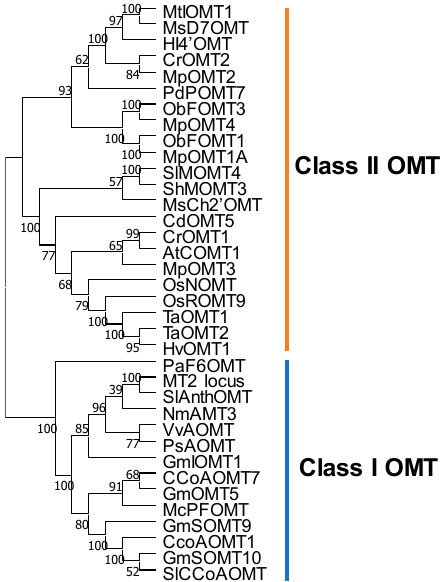
Figure 5. Phylogenetic tree of representative OMT genes. Class I OMT genes, including caffeoyl CoA OMTs and anthocyanin OMTs; class II OMTs, including caffeic acid OMTs, flavonoid OMTs and isoflavone OMTs. The tree was built by MEGAX [97]. The neighbor-joining method was used for clustering. The percentages of replicate trees in the bootstrap test (1000 replicates) are shown next to the branches. The evolutionary distances were computed using the p-distance method and are displayed in the units of the number of amino acid differences per site. Accession numbers: CCoAOMT1, At4g34050; CCoAOMT7, At4g26220; GmSOMT9, Glyma.17g171100; GmSOMT10, Glyma.07G214700; GmIOMT1, Glyma.05g14700; GmOMT5, Glyma.05G223400; VvAOMT. NP_001290011;